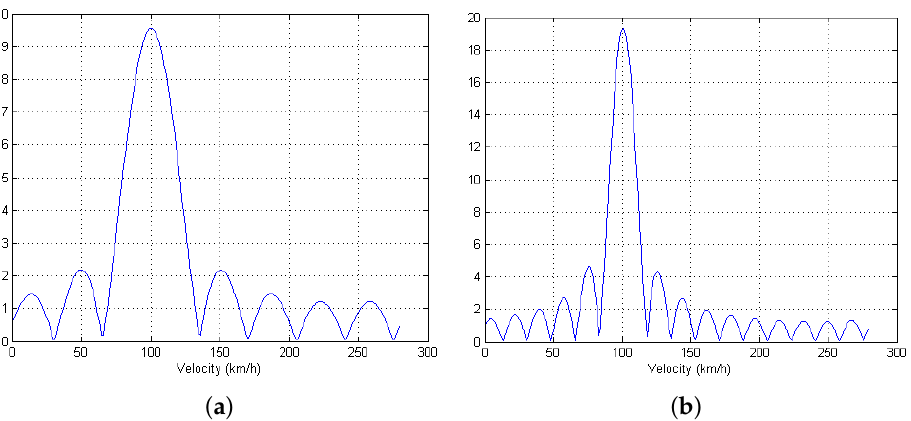
Figure 7. Doppler frequency (velocity) profile when Doppler estimation method in Section 6 is used with ( a ) N sym = 8 and ( b ) N sym =